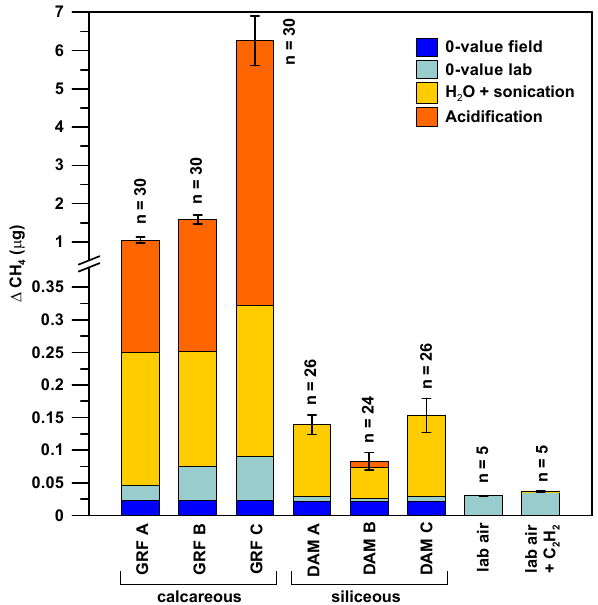
Fig. 2. Cumulative, average amount of CH 4 released from minia- ture soil cores after treatments to disturb the soil structure. Note the break and variable scaling of the y axis. Zero-values in the field rep- resent the estimated amount of CH 4 contained in enclosed ambient air; 0-values in the lab represent the (additional) amount of CH 4 released during transport and storage. Error bars denote standard deviation of the mean of the total amount of CH 4 in the